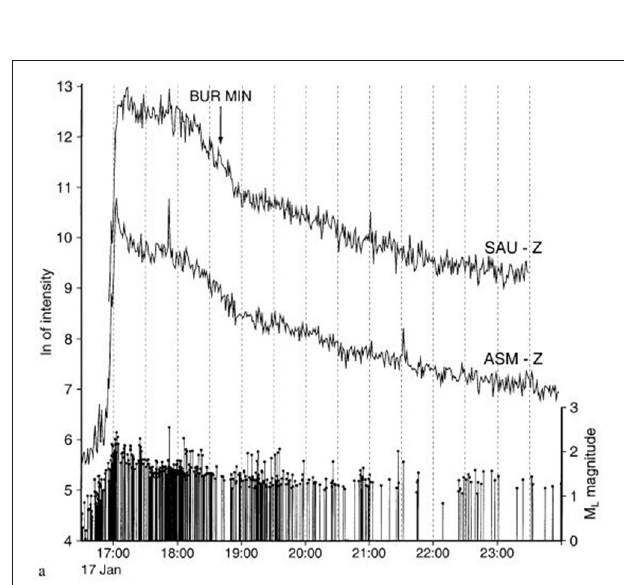
FIGURE 6 | Seismicity associated with the beginning of the Hekla eruption of 1991. Plot of tremor amplitude (top) at two seismograph stations in South Iceland, SAU and ASM, and the magnitude of earthquakes at Hekla (bottom) . From Soosalu et al. (2003). Reproduced with the permission of the copyright holder, Springer